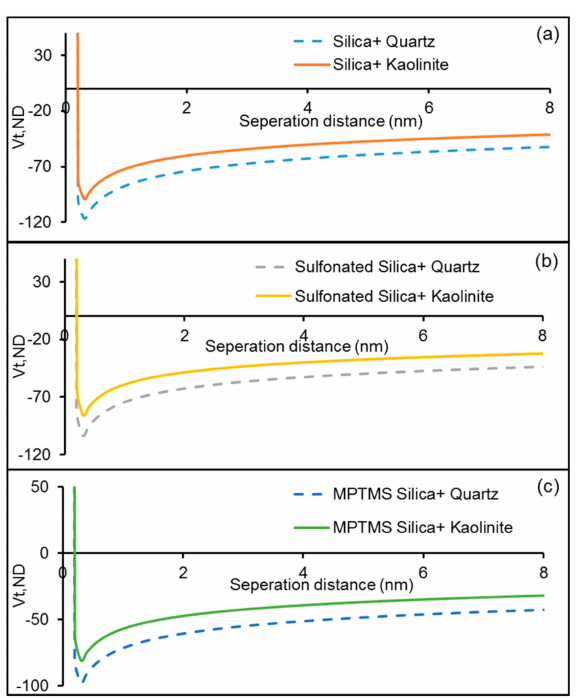
Figure 12. Interaction potential between the mineral and ( a ) unmodified silica; ( b ) sulfonated silica; and ( c ) unmodified silica + MPTMS.